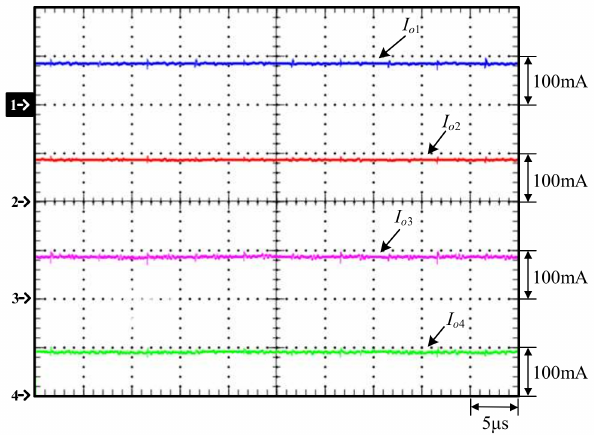
Figure 29. Measured waveforms relevant to 25% of the rated load: (1) I o 1 ; (2) I o 2 ; (3) I o 3 ; (4) I o 4